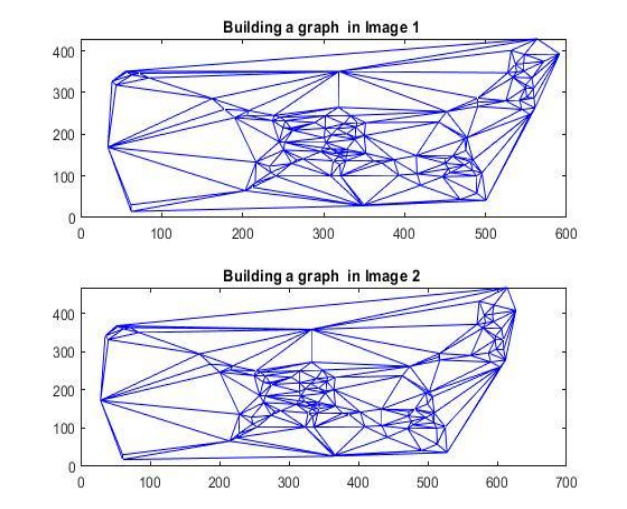
Figure 7 : Building a graph based on the adjacency matrix Algorithm I: